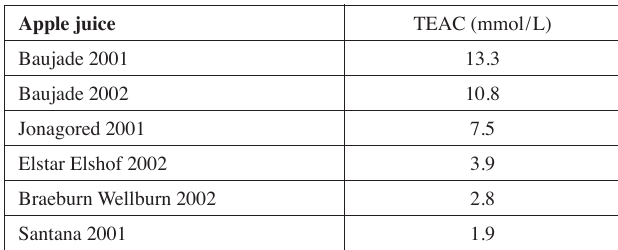
Tab. 3: TEAC values (ABTS radical de colour isation) of selected apple